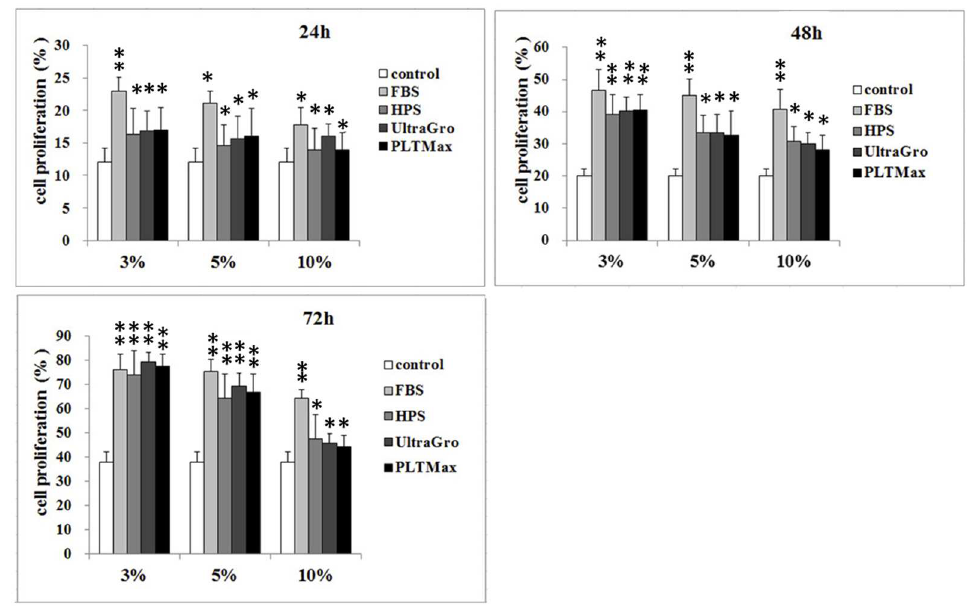
Fig 2. Cell proliferation: The effects of different blood derivativeson cellular proliferation with MTS assay. At 24 hours and 48 hours, corneal epithelialcells incubatedwith fetal bovineserum had significantly higherproliferativeresponses than those incubatedin humanperipheral serum, UltraGRO humanplatelet lysate (HPL), and PLTMax HPL. At 72 hours, there was no difference among these 4 products in 3% and 5% preparations. At 24, 48, and 72 hours, the proliferativeresponses showed no statistical difference between 3% and 5% blood derivative preparations. However, 10% preparation demonstrated poorer proliferativeresponse comparedto 3% and 5% preparations at all time points. FBS: fetal bovine serum, HPS: human peripheral serum. UltraGRO: Human plateletlysate from Helios pharmaceutical. PLTMax: Human platelet lysate from Mill Creek pharmaceutical. * indicated p < 0.05. ** indicated p < 0.01 comparedto the control group that was without blood derivative in culture media.